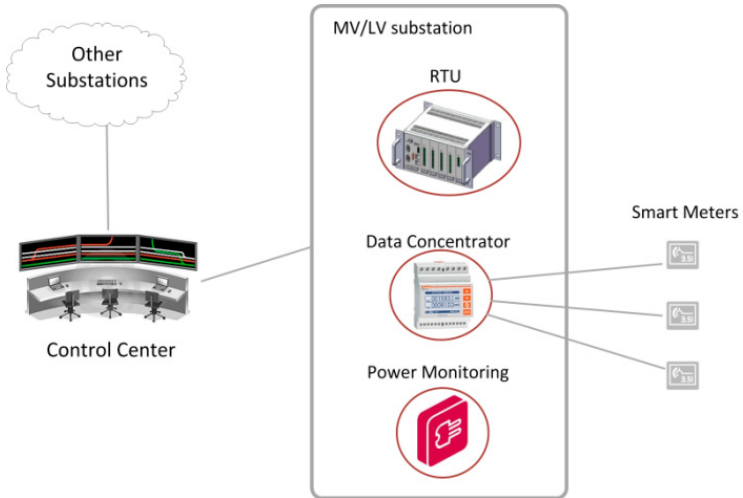
Figure 6. Monitoring options in a substation.